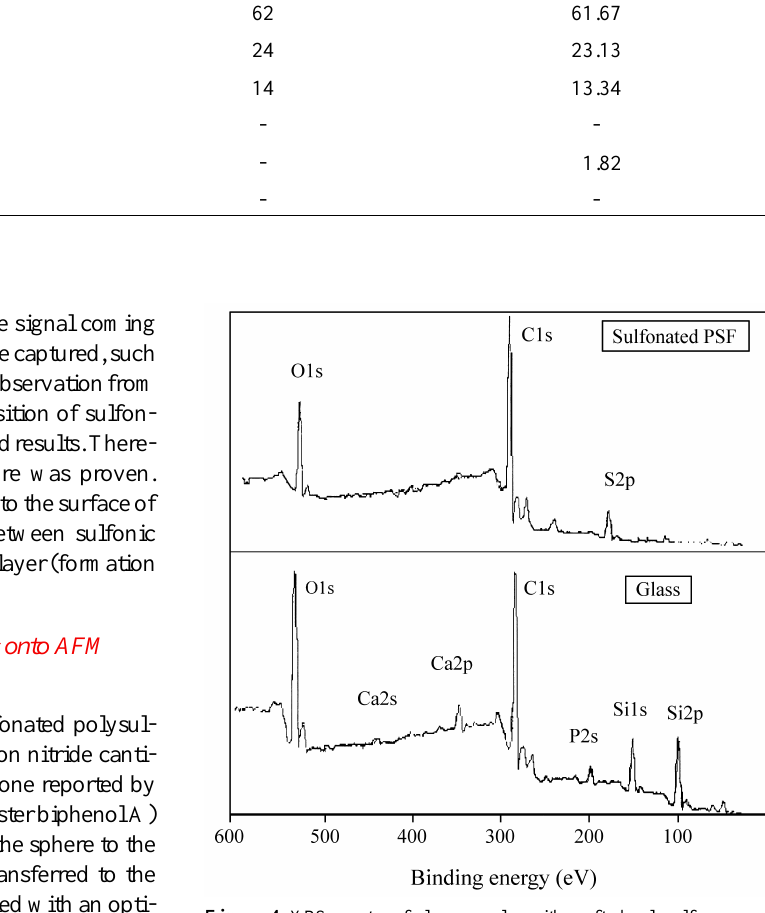
Table 1. Comparison between theoretical composition and results obtained from XPS of glass surfaces grafted with modified polysulfone. Elements